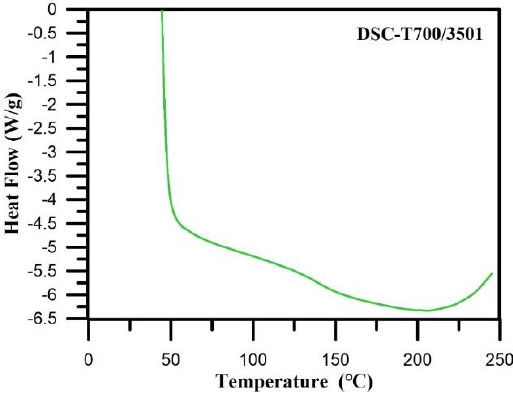
Figure 7. Differential scanning calorimetry (DSC) analyses of T700/3501CFRP material.